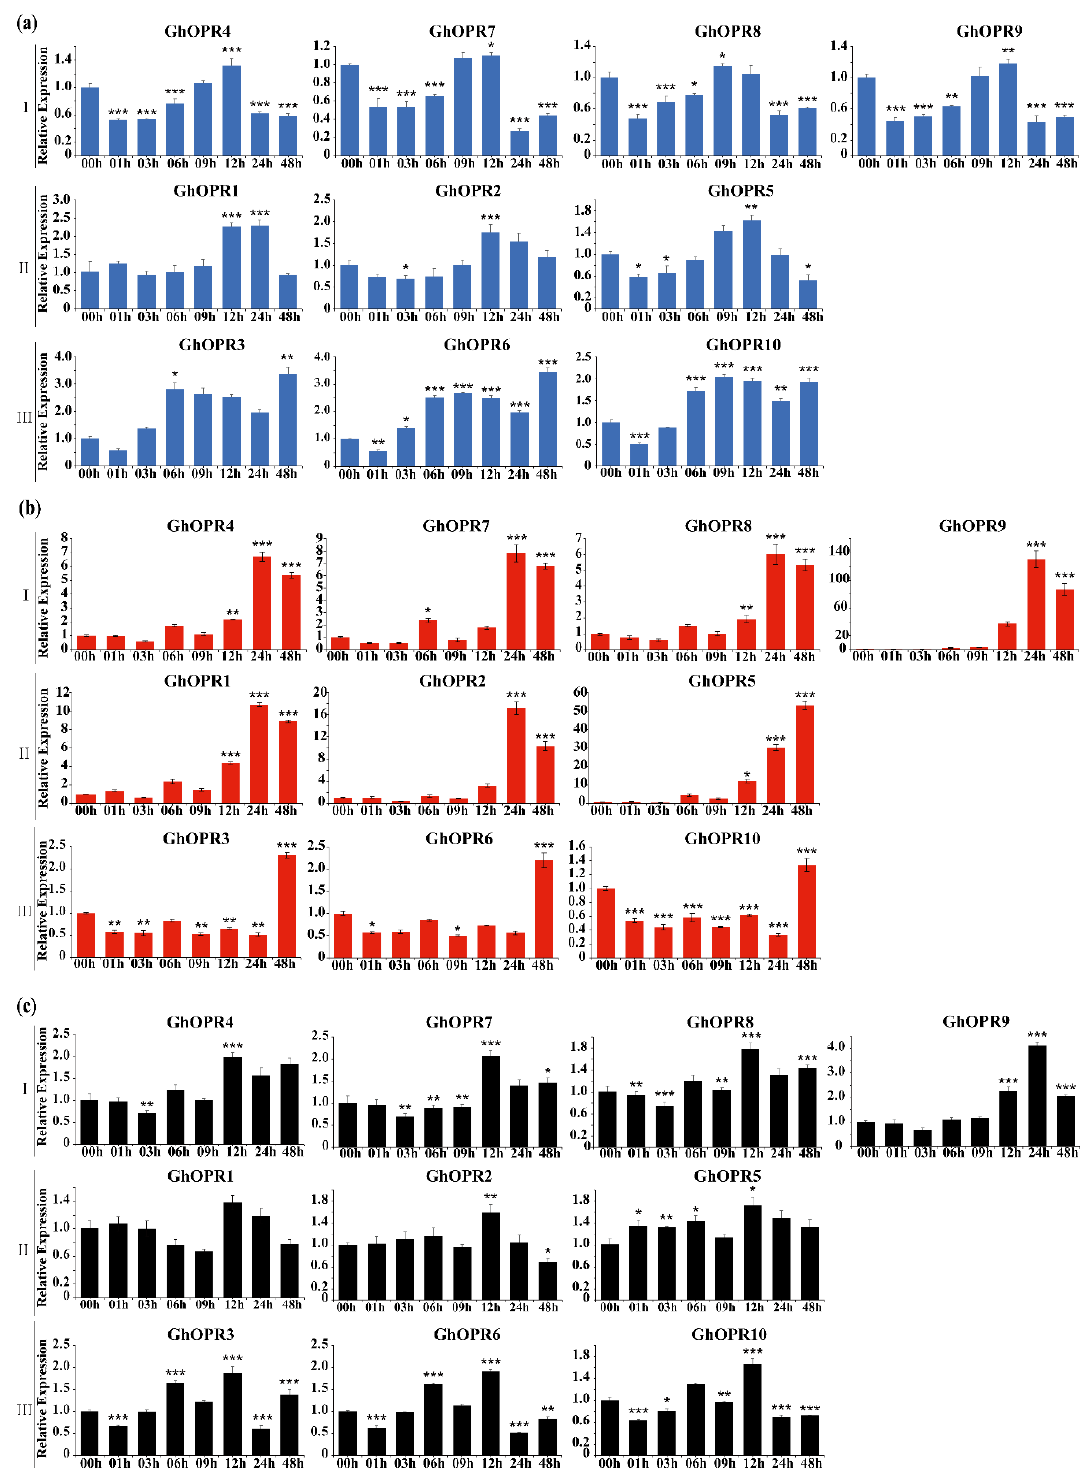
Figure 5. Analysis expression levels of GhOPRs under V. dahliae inoculation by RT-qPCR. The blue, red and black colors represent the sample of leaves, roots and stems, respectively. ( a ) The expression levels of GhOPRs under V. dahliae inoculation in leaf. ( b ) The expression levels of GhOPRs under V. dahliae inoculation in root. ( c ) The expression levels of GhOPRs under V. dahliae inoculation in stem. The samples were collected at 0, 1, 3, 6, 9, 12, 24, and 48 h after Vd080 inoculation. Values represent means ± standard deviation of three replicates. Asterisks reveal the gene significantly higher or lower in other time points than in 0 h by t -test (* p < 0.05, ** p < 0.01, *** p < 0.001).